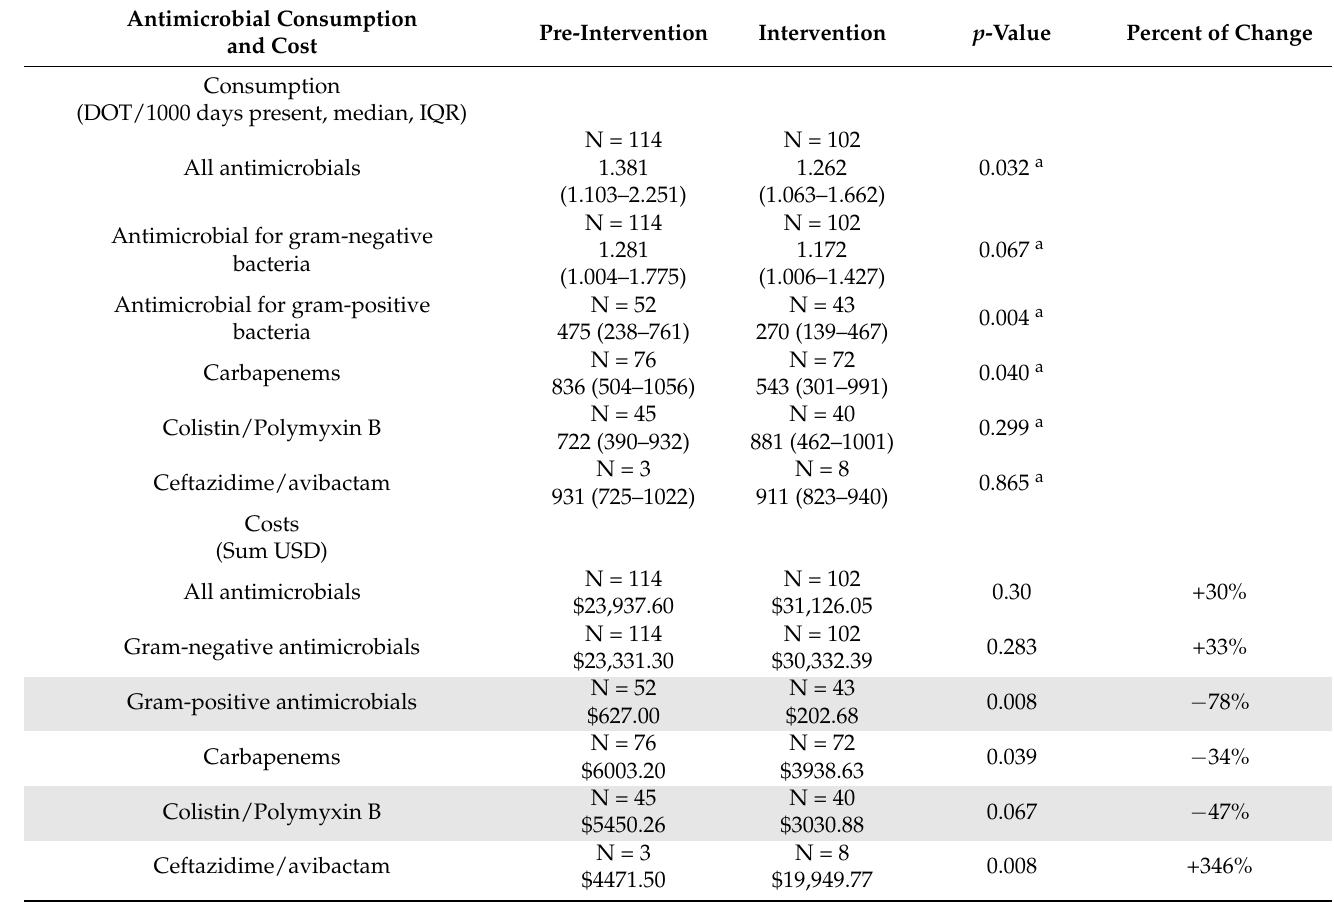
Table 4. Antimicrobial consumption in DOT per 1000 days present and costs following culture collection (21 days).